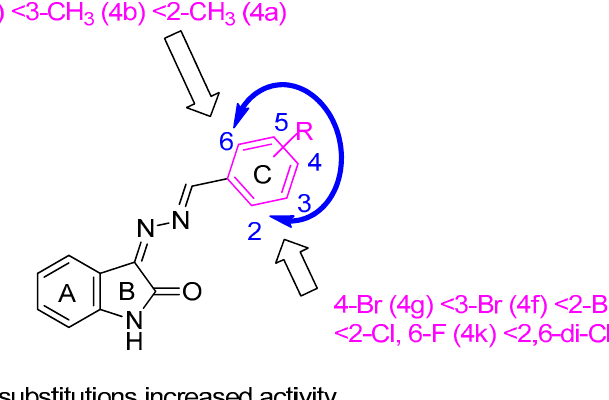
Figure 3. Structure–activity relationship (SAR) analysis of compounds 4a – k .